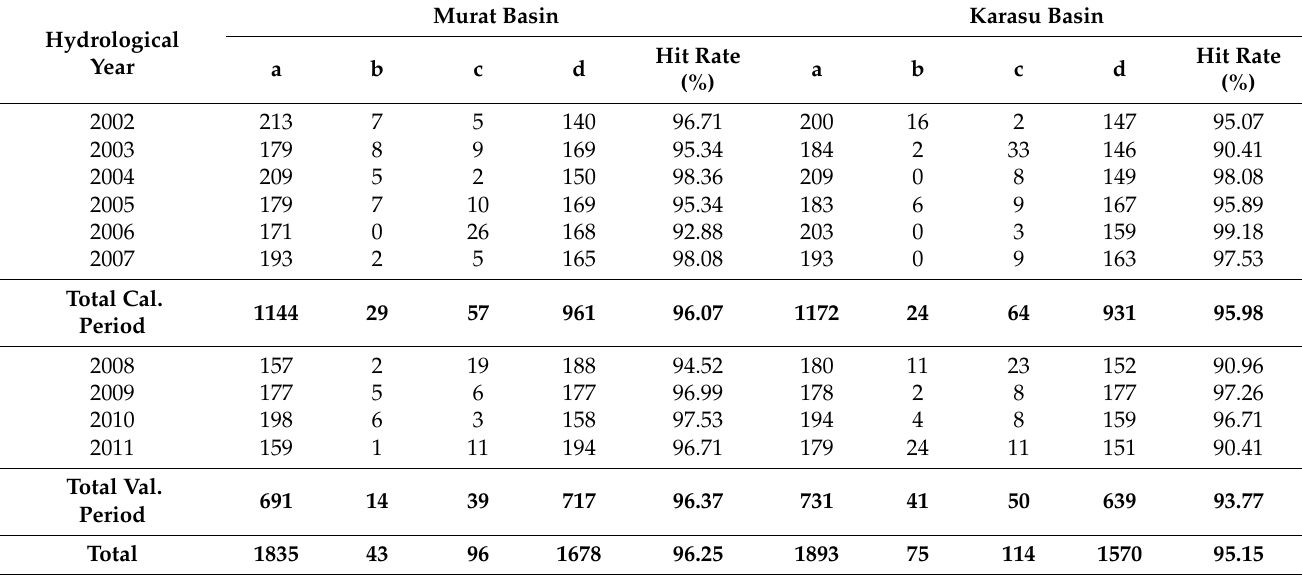
Figure 4. SWE (default/calibrated)–SCA comparison chart for ( a ) Murat and ( b ) Karasu basin in the modeling period. Table 3. Hit rates for SWE-SCA comparison charts for calibrated snow